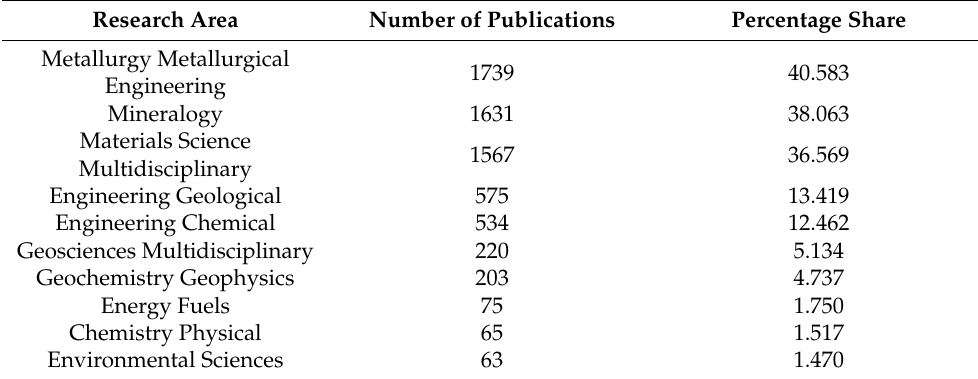
Table 2. Most frequent research areas associated with the publications concerning the